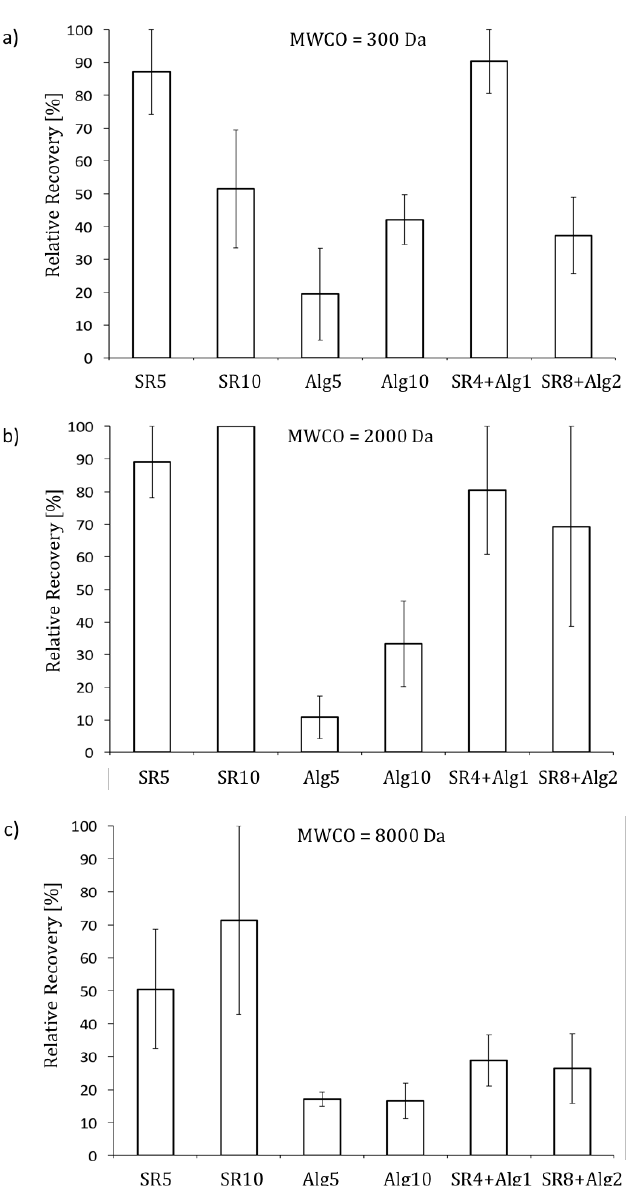
Figure 4. Relative recovery during post-clean water filtration ( a ) MWCO = 300 Da; ( b ) MWCO = 2000 Da; ( c ) MWCO = 8000 Da; SR5: SRNOM at 5 mg/L; SR10: SRNOM at 10 mg/L; Alg5: Alginate at 5 mg/L; Alg10: Alginate at 10 mg/L; SR4 + Alg1: SRNOM at 4 mg/L + alginate at 1 mg/L; SR8 + Alg2: SRNOM at 8 mg/L + alginate at 2 mg/L; error bars correspond to observed minimum/maximum values).